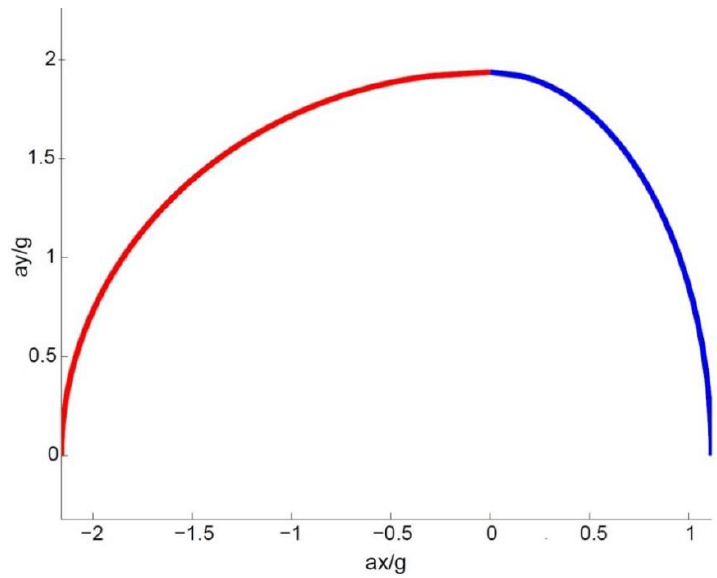
Figure 1. Friction ellipse for 𝑣 = 50 km/h, grip effect only (blue line: acceleration, red line: braking).